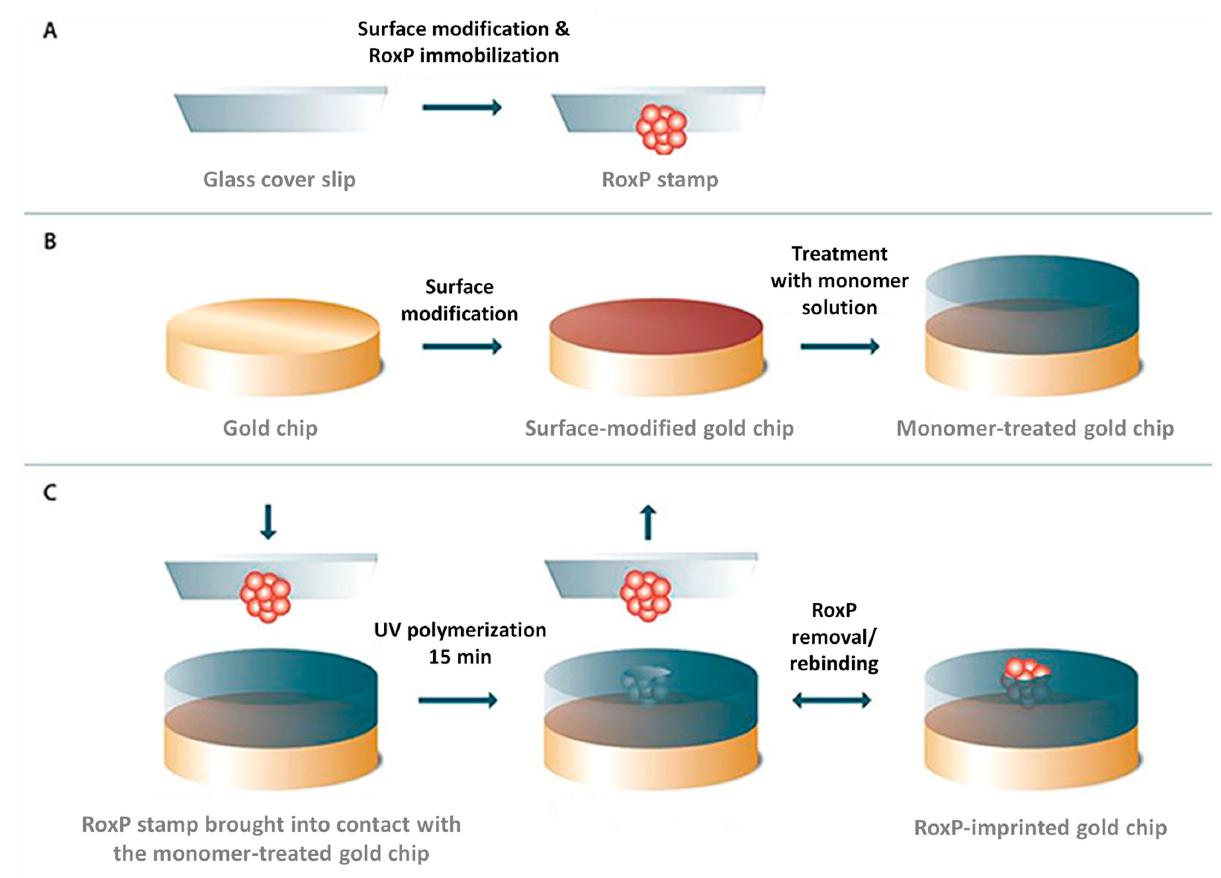
Figure 5. MIP-based SPR sensor for the bacterial factor RoxP: scheme of the MIP layer preparation by microcontact imprinting. ( A ) Glass cover slip surface modification and RoxP immobilization; ( B ) gold chip surface modification with the monomer; ( C ) microcontact of the RoxP stamp with the monomer-treated gold chip and UV imprinting (Reproduced with permission from [50], Copyright © 2019, American Chemical Society).